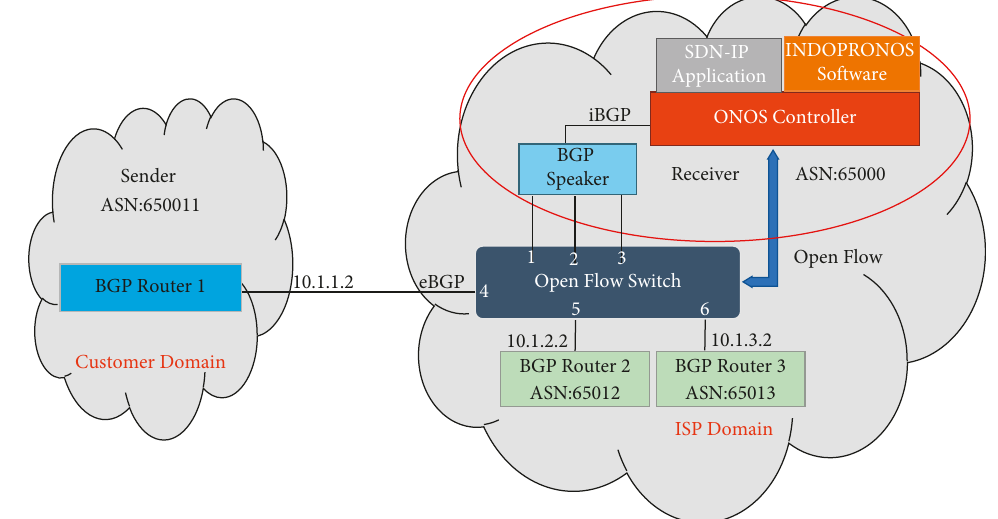
Figure 13: INDOPRONOS framework [27].